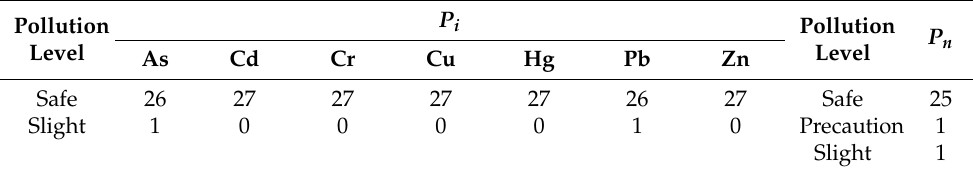
Table 4. Number of different P i and P n levels for ground water samples (n = 27).